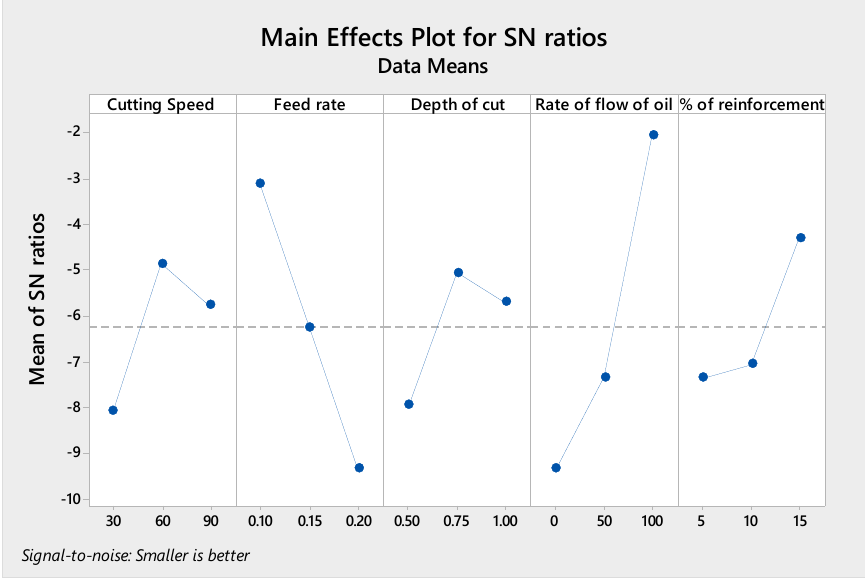
Figure 7. Signal to noise (S/N) ratio plot for surface roughness.